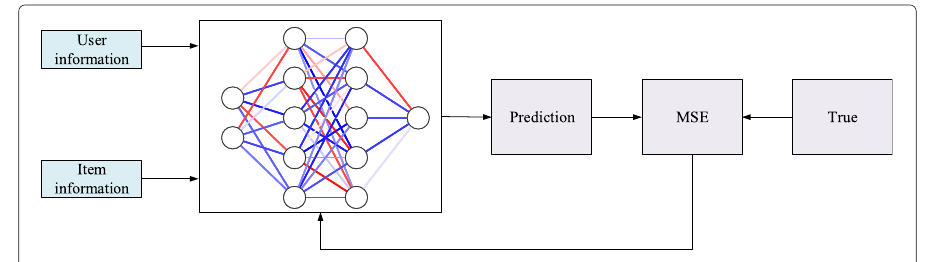
Fig. 2 The proposed contents prediction